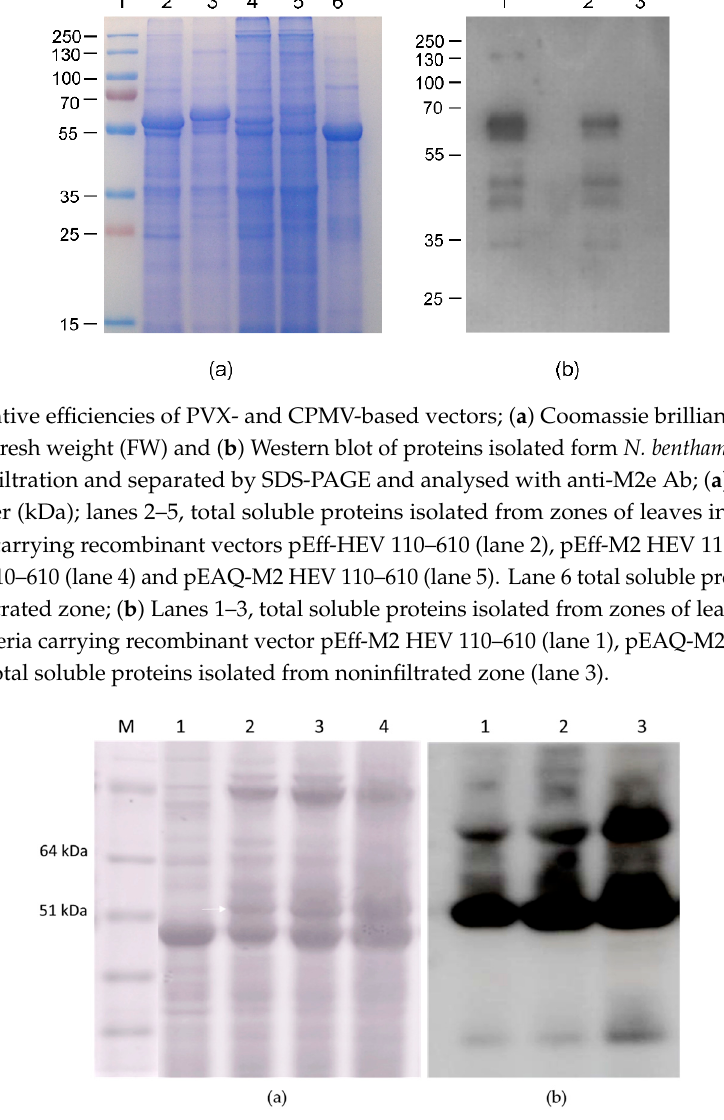
Figure 9. ( a ) SDS-PAGE of 3 mg FW; M. Molecular weight marker (kD); 1. Plant inoculated with empty pEAQ- HT ; 2. TSP extracted at two dpi; 3. TSP extracted at four dpi; 4. TSP extracted at six dpi; and ( b ) Western blot with anti-HEV ORF2 mAb of TSP extracted from M2 HEV 110–610 at two dpi (lane 1), at four dpi (lane 2), and at six dpi (lane 3).